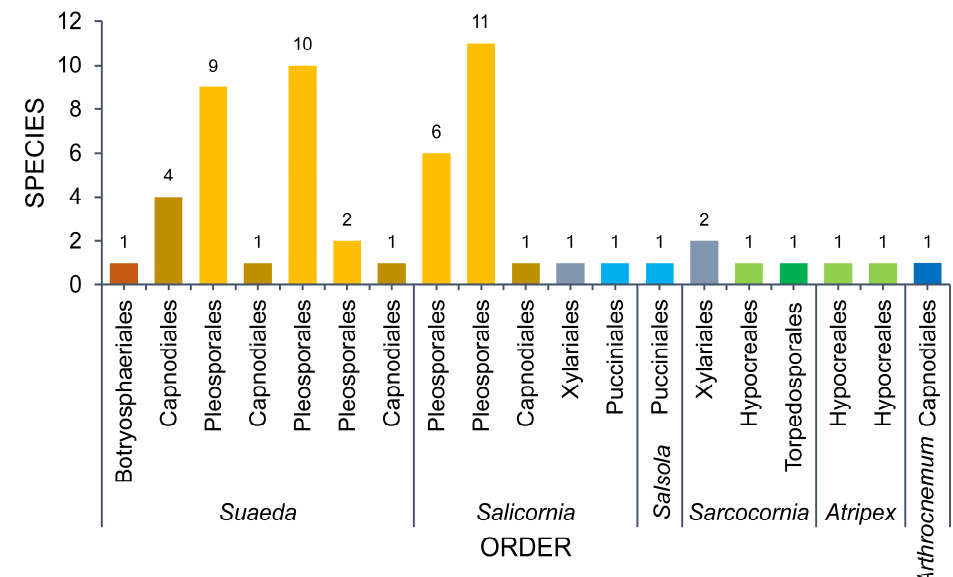
Figure 9. The number of taxa observed from Amaranthaceae.